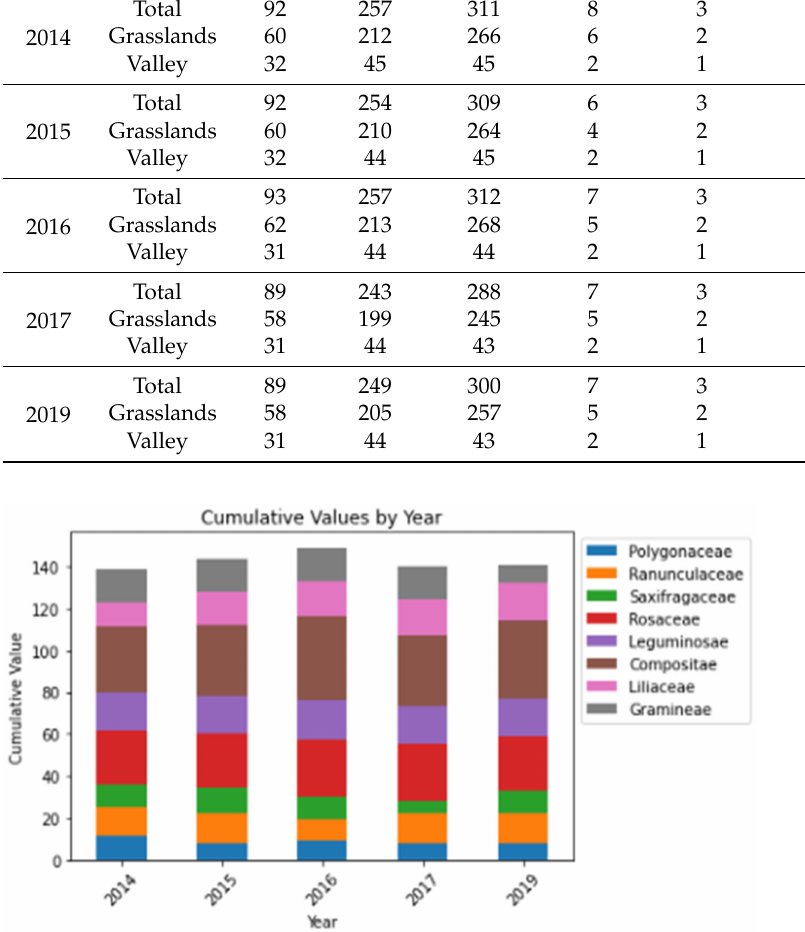
Figure 2. Number of taxa in each family present each year. The plant species numbers according to Raunkiær’s life-form classification are shown in Figure 3. The numbers of each life form changed every year but had a different pattern. The numbers of two types, geophyte (G) and helophyte (H), fluctuated as a function of the event each year; they increased after thinning, decreased after grazing, and